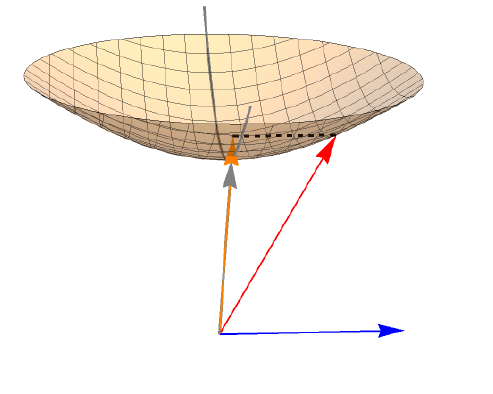
Figure 9. The unit timelike vector n B ( u ) (shown in gray) determined by the unit timelike vector (cid:4)( u ) and by the spacelike 3-vector B (shown in blue). The timelike 3-vector (cid:4)( u ) is shown in red, while (cid:4) B ( u ) is shown in orange. As u varies in D, the vector n B ( u ) describes the hyperbola (shown in gray) obtained by intersecting the future sheet of the unit hyperboloid with the Minkowski